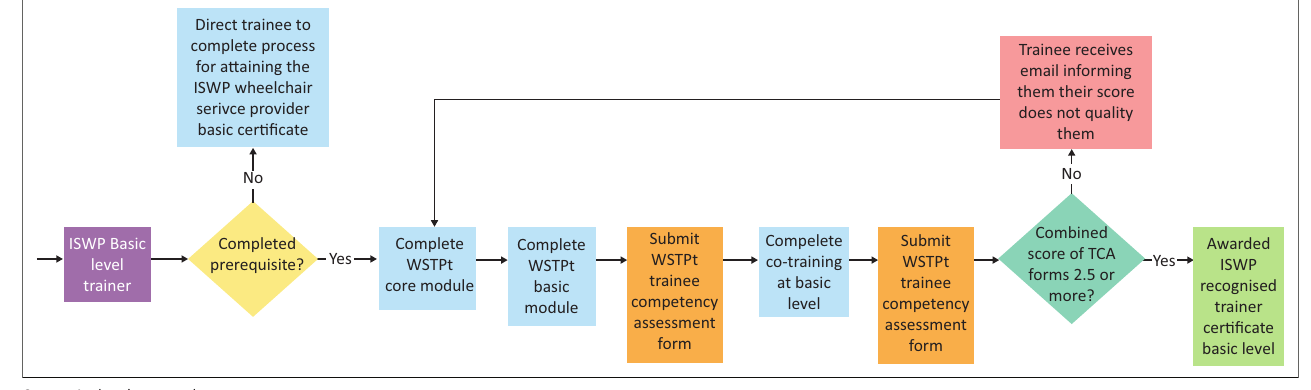
FIGURE 1: ISWP training recognition